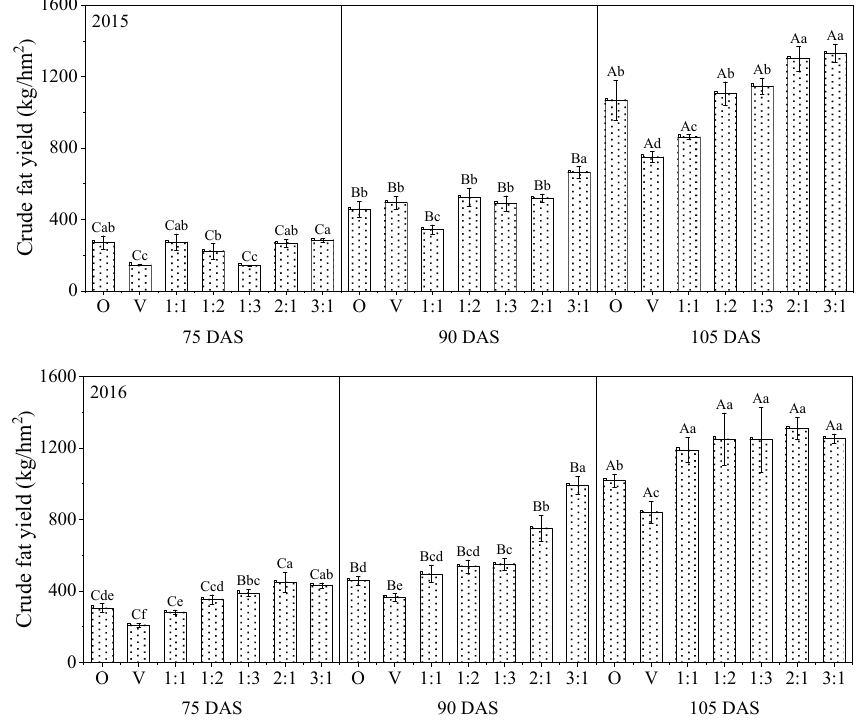
Figure 4. The effect of different intercropping ratios of oat and common vetch on crude fat yield of forage.